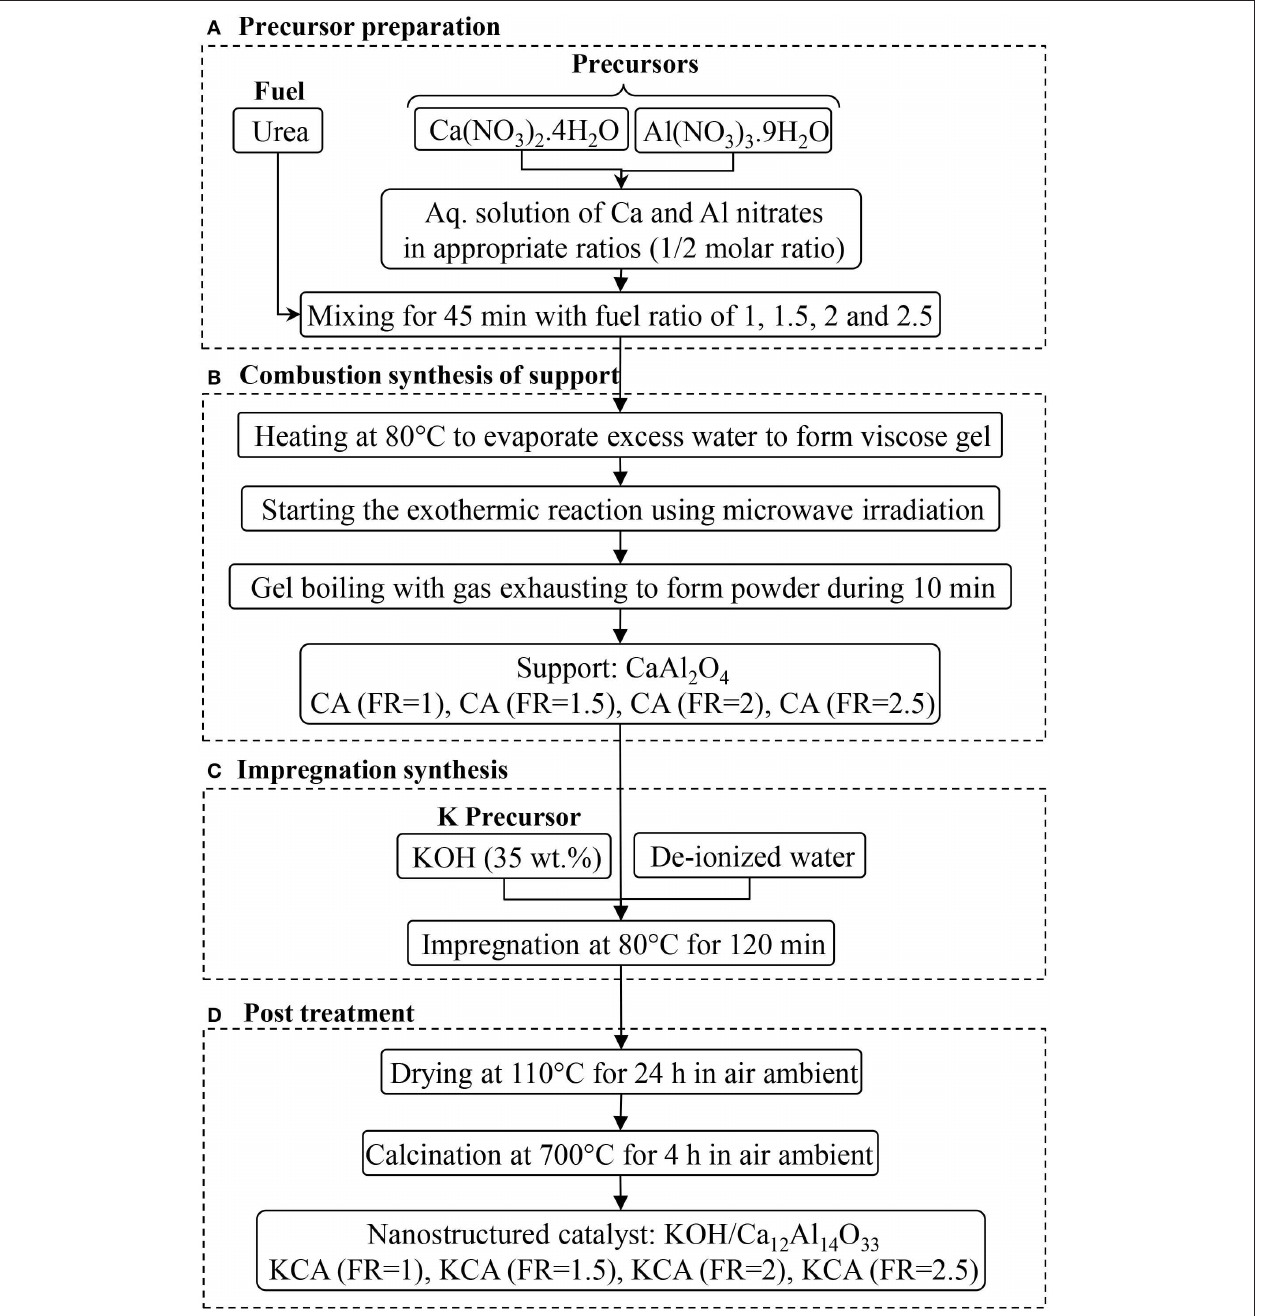
FIGURE 1 | Microwave assisted combustion synthesis of KOH/Ca 12 Al 14 O 33 nanostructured catalysts with various fuel ratios. (A) Precursor preparation. (B) Combustion synthesis of support. (C) Impregnation synthesis. (D) Post treatment.